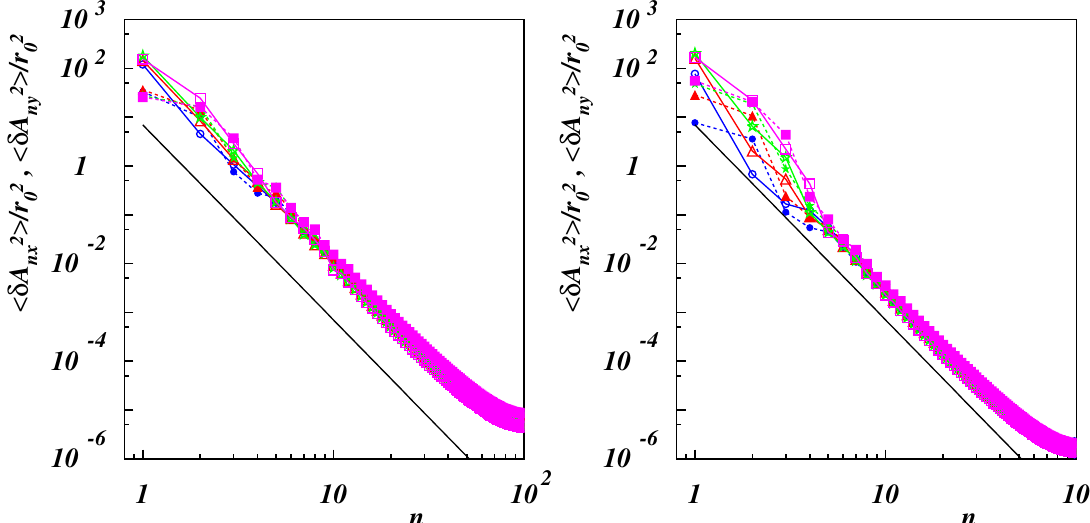
Figure 8. Variance of the mode components A nx (open symbols with solid lines) and A ny (solid symbols with dashed lines) as functions of mode number n for L p / L = 0.5 ( left ), 2 ( right ) and Wi = 10 ( • ) ,25 ( (cid:78) ) ,50 ( (cid:63) ) ,100 ( (cid:4) ) . The slope of the solid lines is −